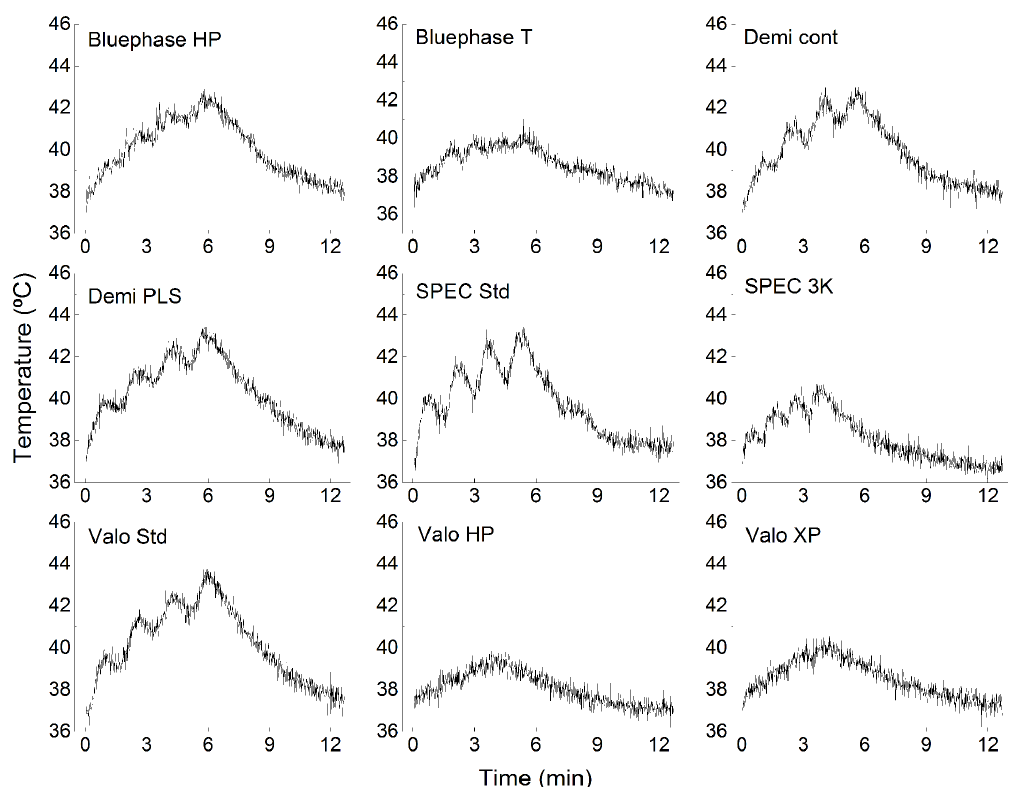
Figure 2. Mean pulp temperature values after each period of light exposure for all LED LCUs and exposure modes. 3. Discussion